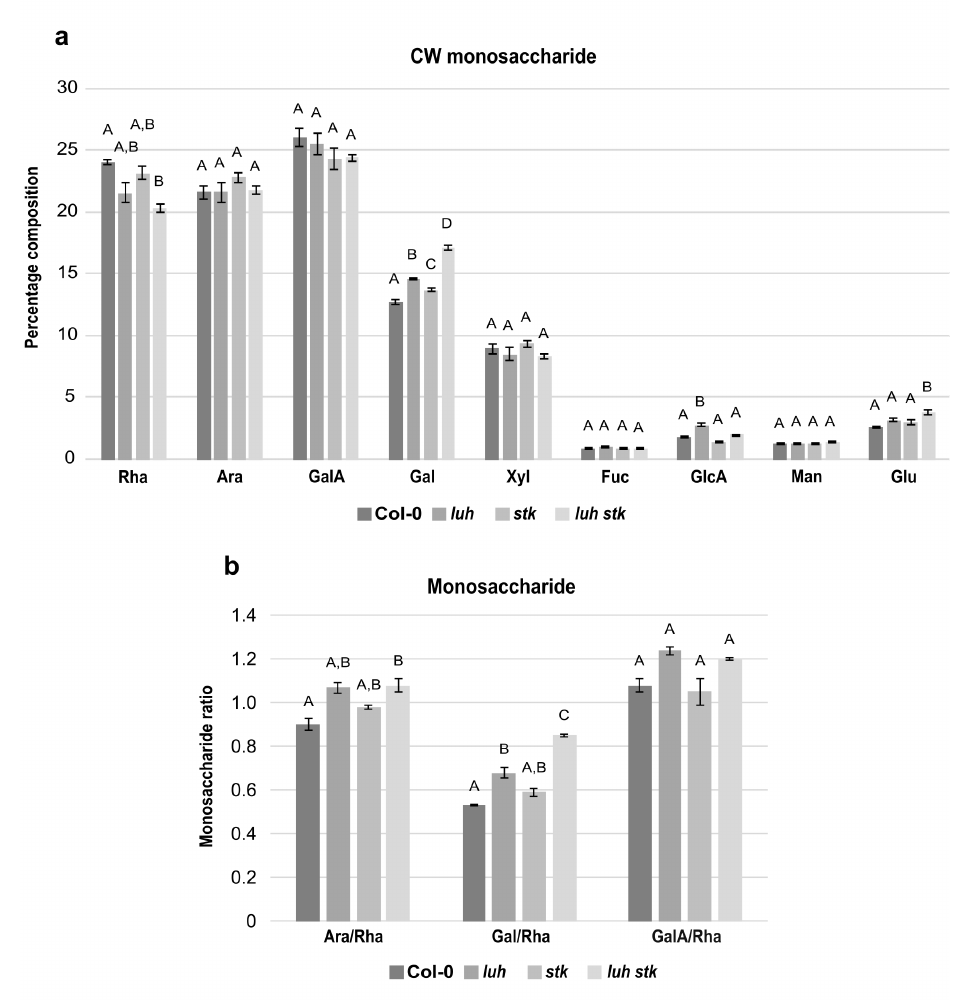
Figure 3. Total cell wall monosaccharide composition in seeds from Col-0 (WT), luh and stk single mutants, as well as the luh stk double mutant. ( a ) Monosaccharide composition. Rha, rhamnose; Ara, arabinose; GalA, galacturonic acid; Gal, galactose; Xyl, xylose; Fuc, fucose; GlcA, glucuronic acid; Man, mannose; Glc, glucose. Statistical analyses were performed using ANOVA followed by Tukey’s HSD test; different letters indicate statistically significant differences ( p < 0.01) between WT and the other genotypes, as well as between single mutants and the double mutant. ( b ) Pectin distribution and ramification. Ara/Rha ratio, Gal/Rha ratio, GalA/Rha ratio. Error bars represent the SE of 4 biological replicates. Statistical analyses were performed using ANOVA followed by Tukey’s HSD test; different letters indicate statistically significant differences ( p < 0.01) between WT and the other genotypes, as well as between single mutants and the double mutant.